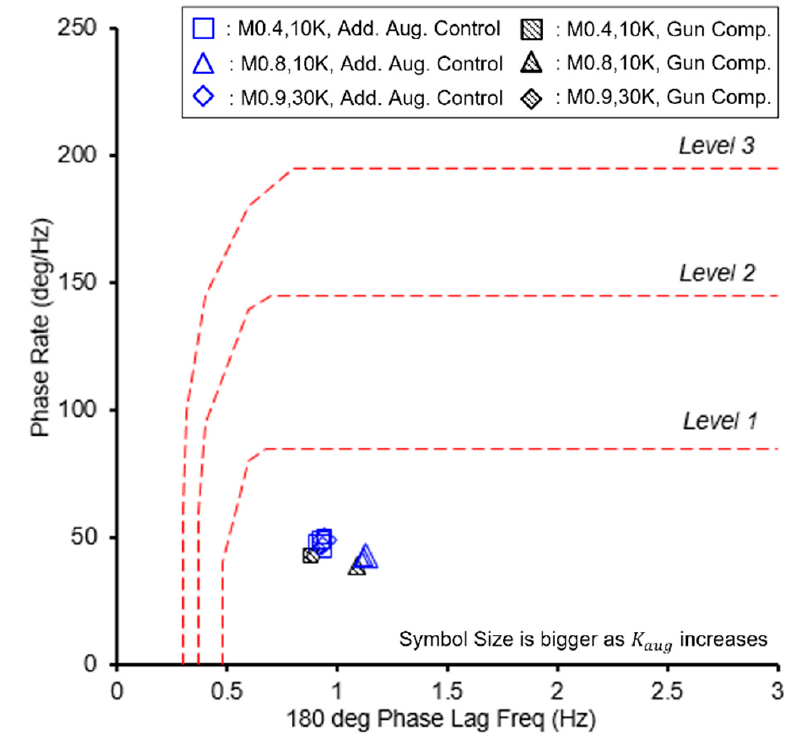
Figure 8. Result of Gibson phase rate analysis.